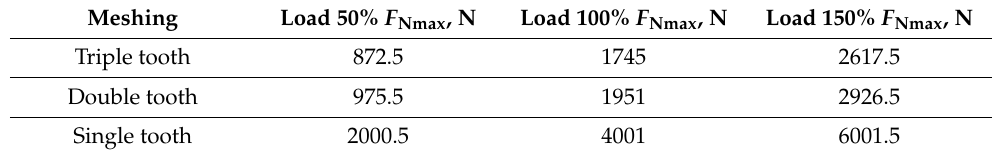
Table 2. External loads during the meshing.